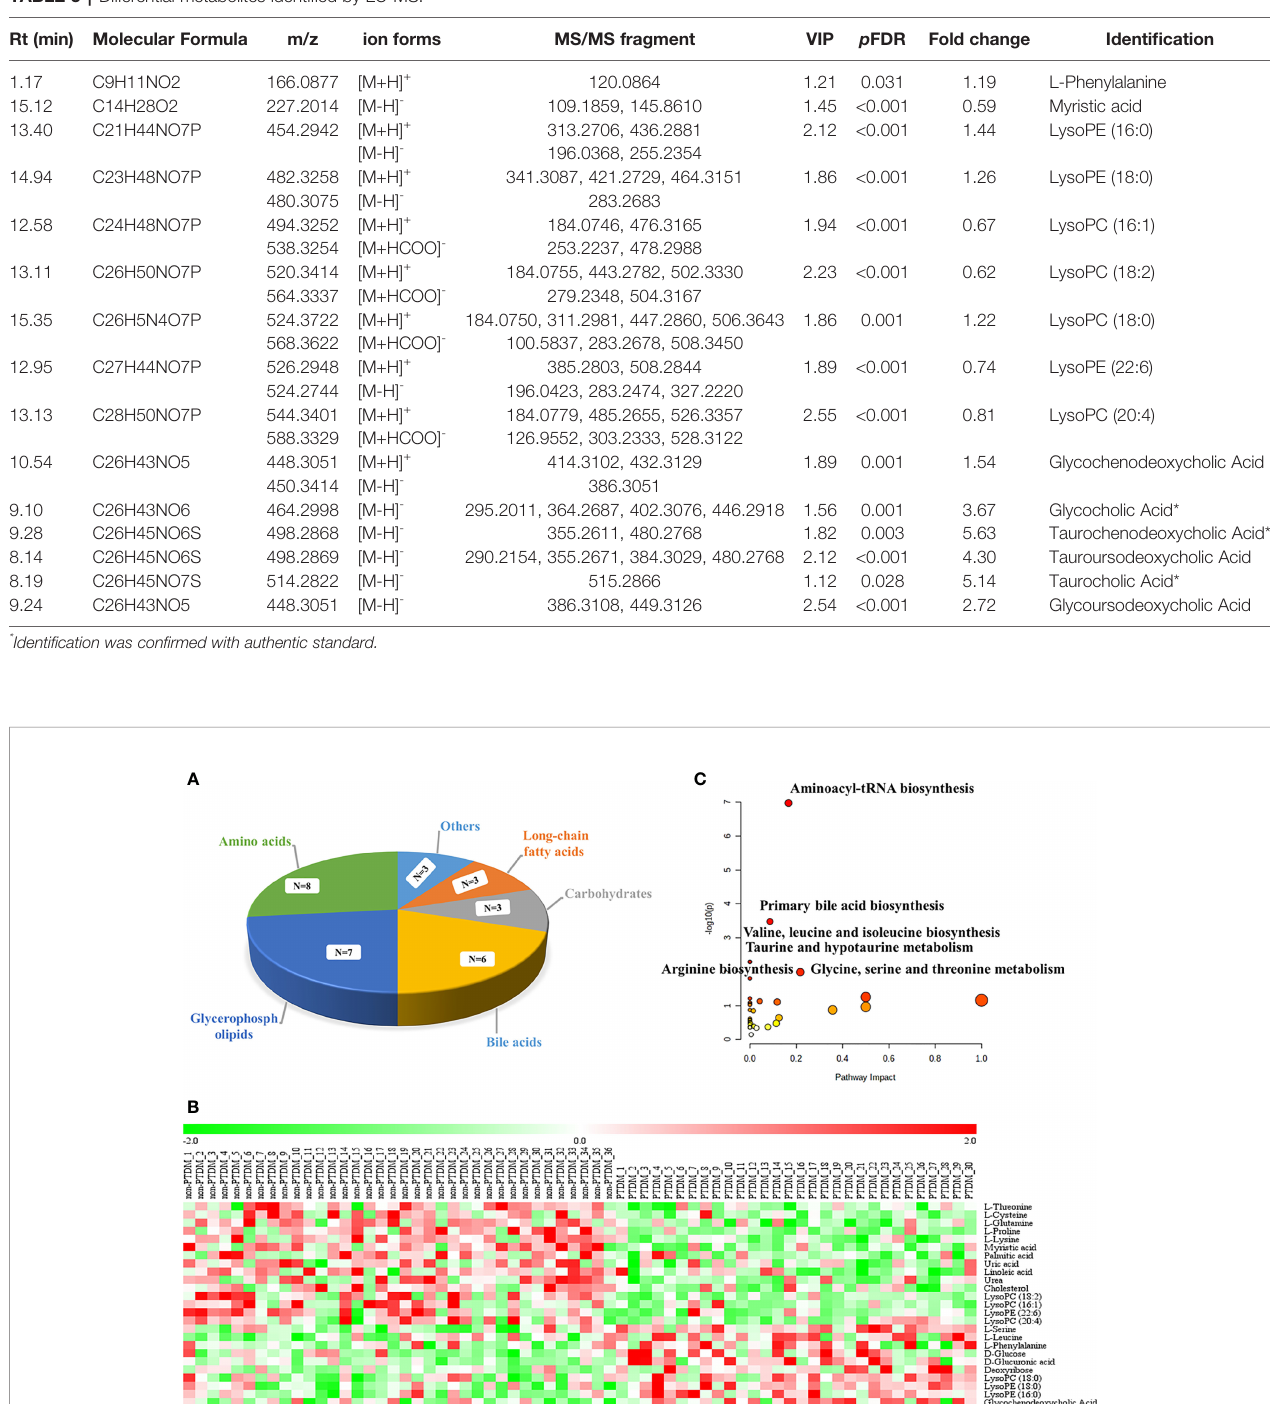
TABLE 3 | Differential metabolites identi fi ed by